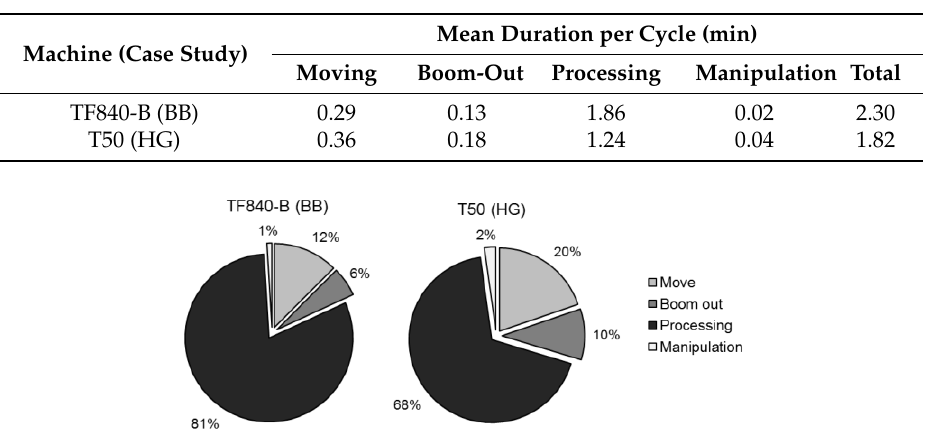
Figure 4. Mean share of cycle duration for the individual work elements in the motor-manual (MM) group.